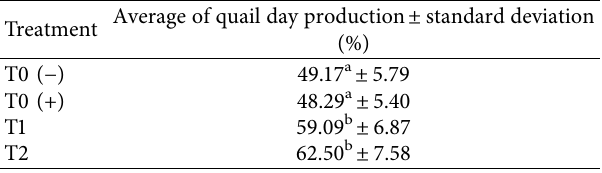
Table 2: Average of quail day production in quails ( Coturnix coturnix japonica ).